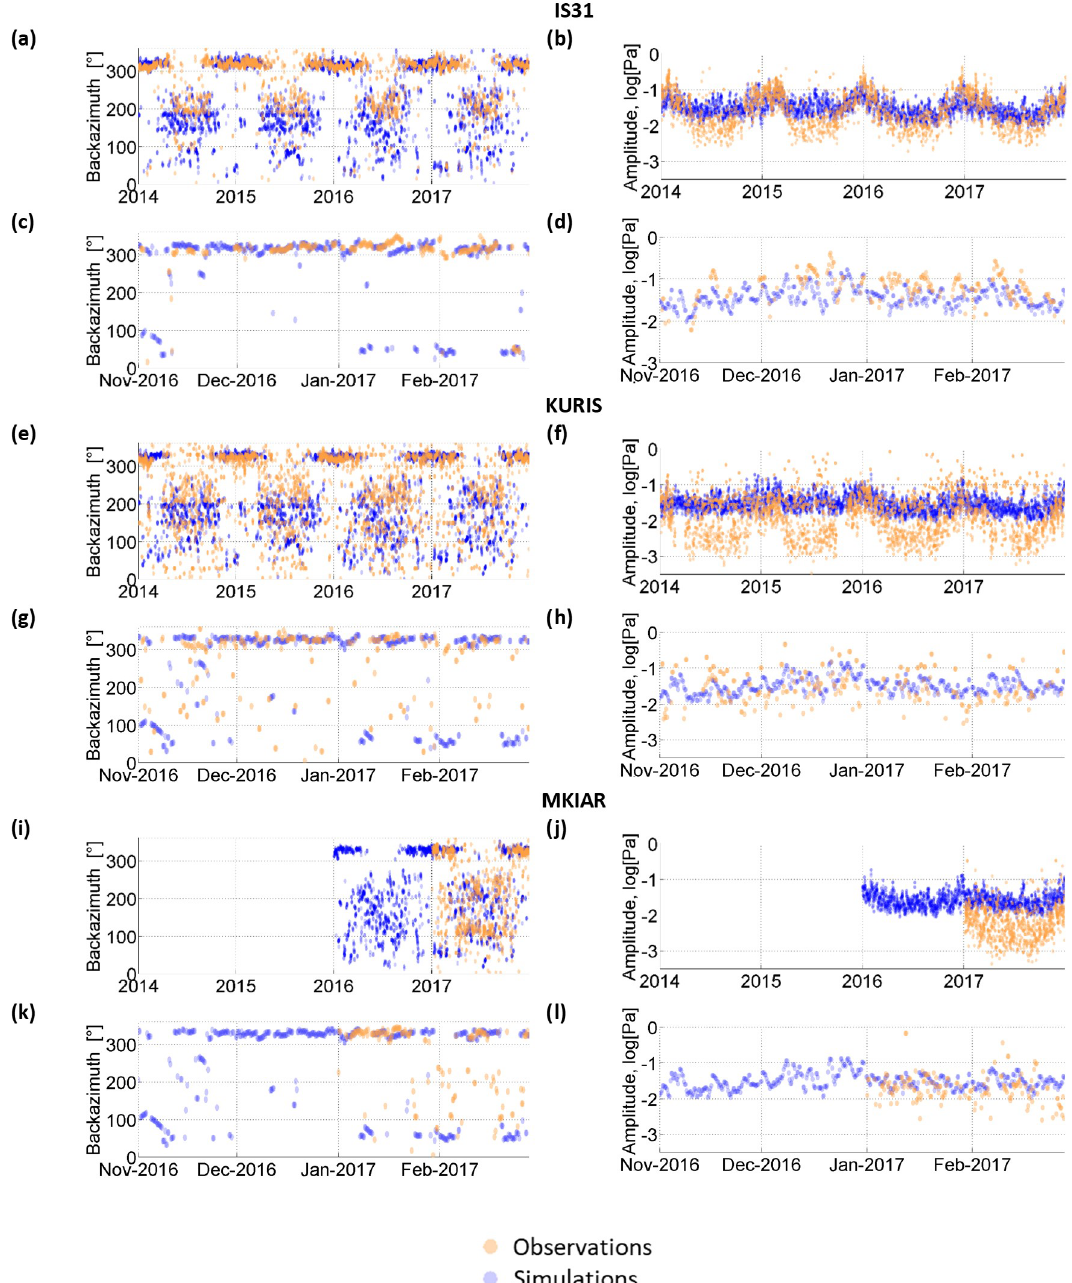
Figure 2. Time variations of observed back-azimuths and amplitudes of microbaroms at IS31 (a–d) , KURIS (e–h) , and MKIAR (i–l) , with a time resolution of 6h from 1 January 2014 to 31 December 2017 (orange circles). Blue circles denote simulated values. Details at IS31 (c, d) , KURIS (g, h) , and MKIAR (k–l)